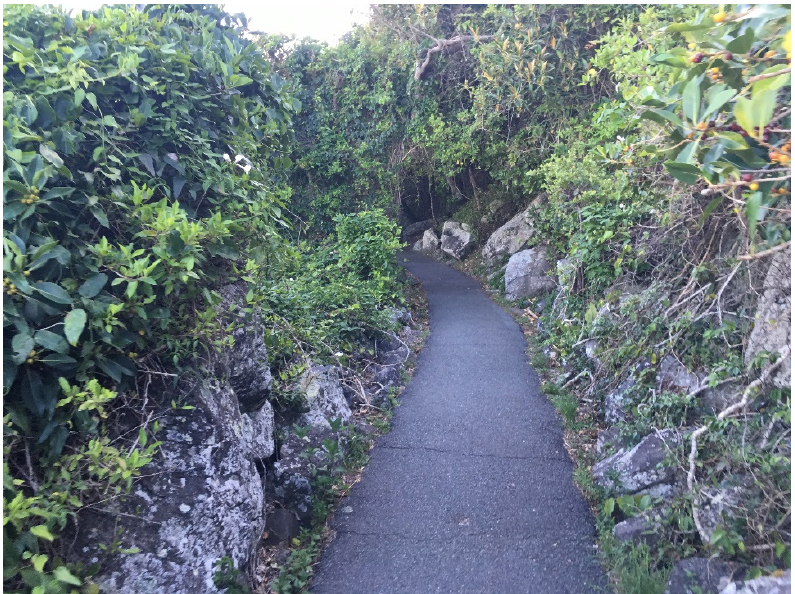
Figure 9. Centreing yourself: A lonely path to show solitary time in nature.